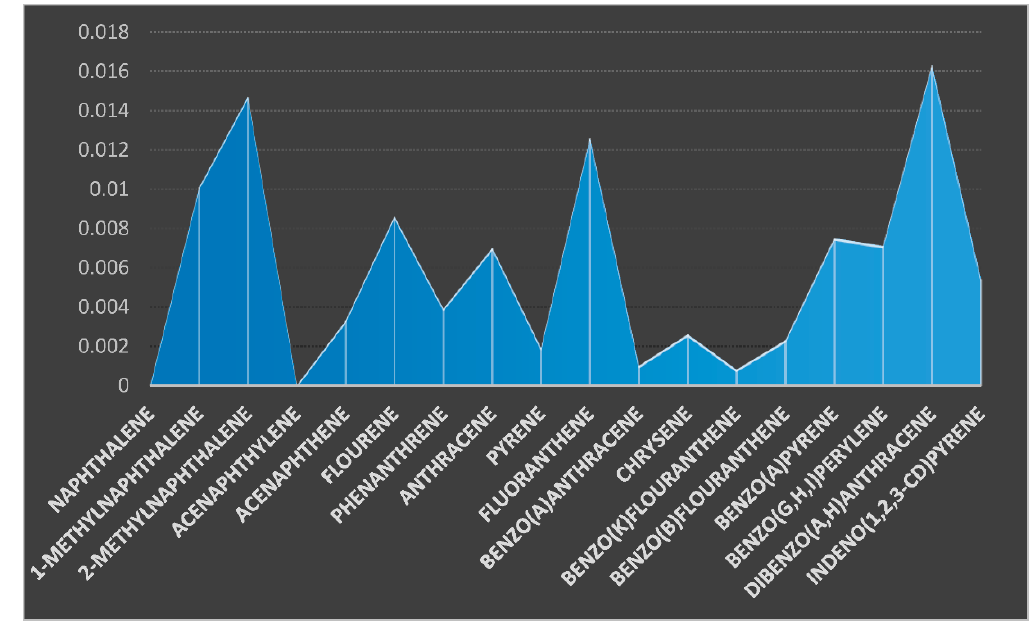
Figure 4. Concentration of PAHs components (µg/kg) in the sediment sample from location 1.